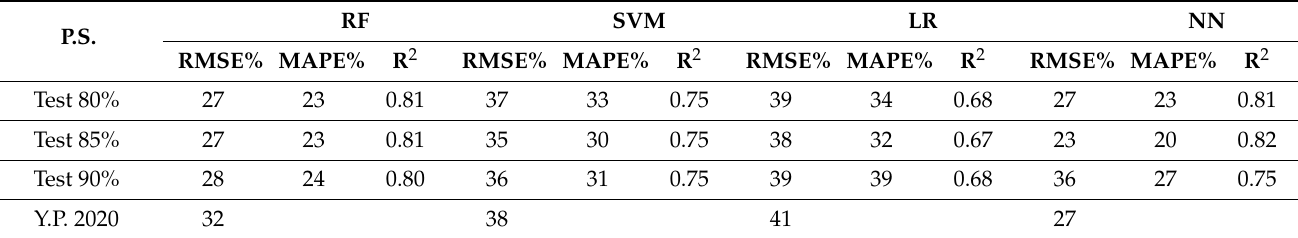
Table 5. Performance of algorithms in estimating yield.